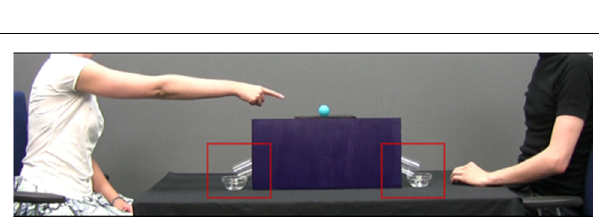
FIGURE 1 |A frame from the demonstration phase showing the Demonstrator distributing balls.